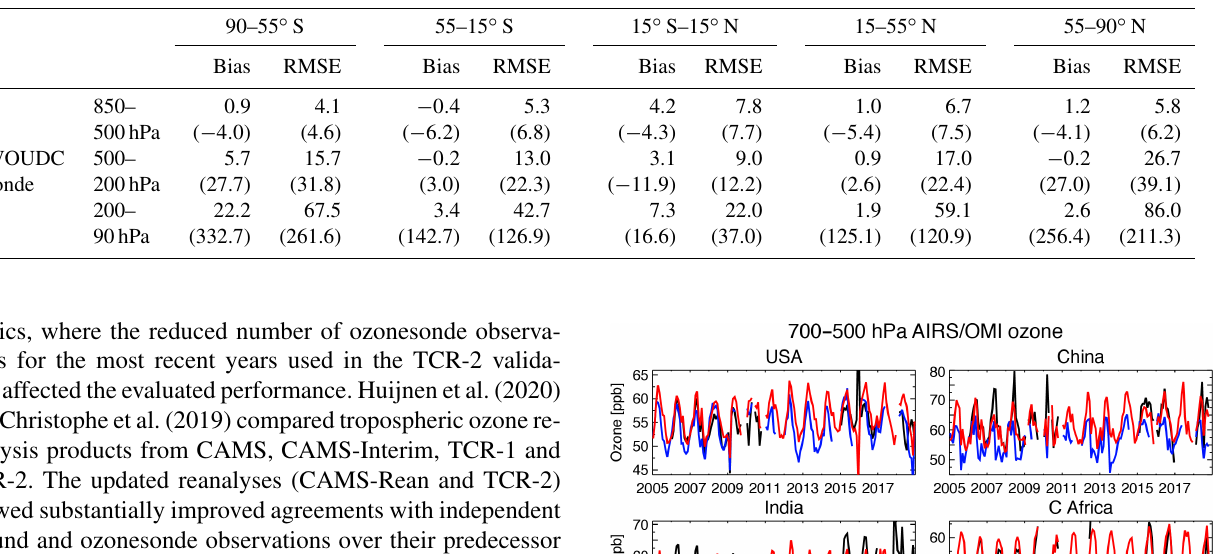
Table 2. Model and ozonesonde observation comparisons for the reanalysis and the control run (in brackets) for 2005–2018 (the units of the RMSE and bias are parts per billion).